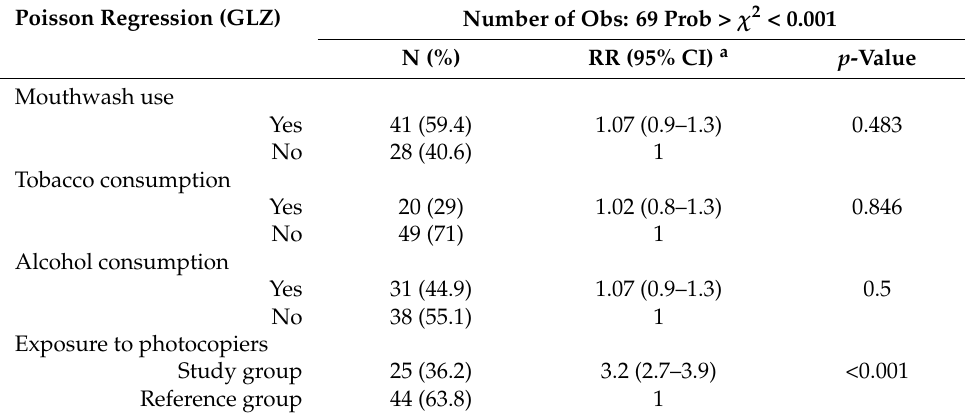
Table 2. Adjusted association between characteristics of study participants, exposure to a working environment with photocopiers, and the frequency of micronucleated cells.